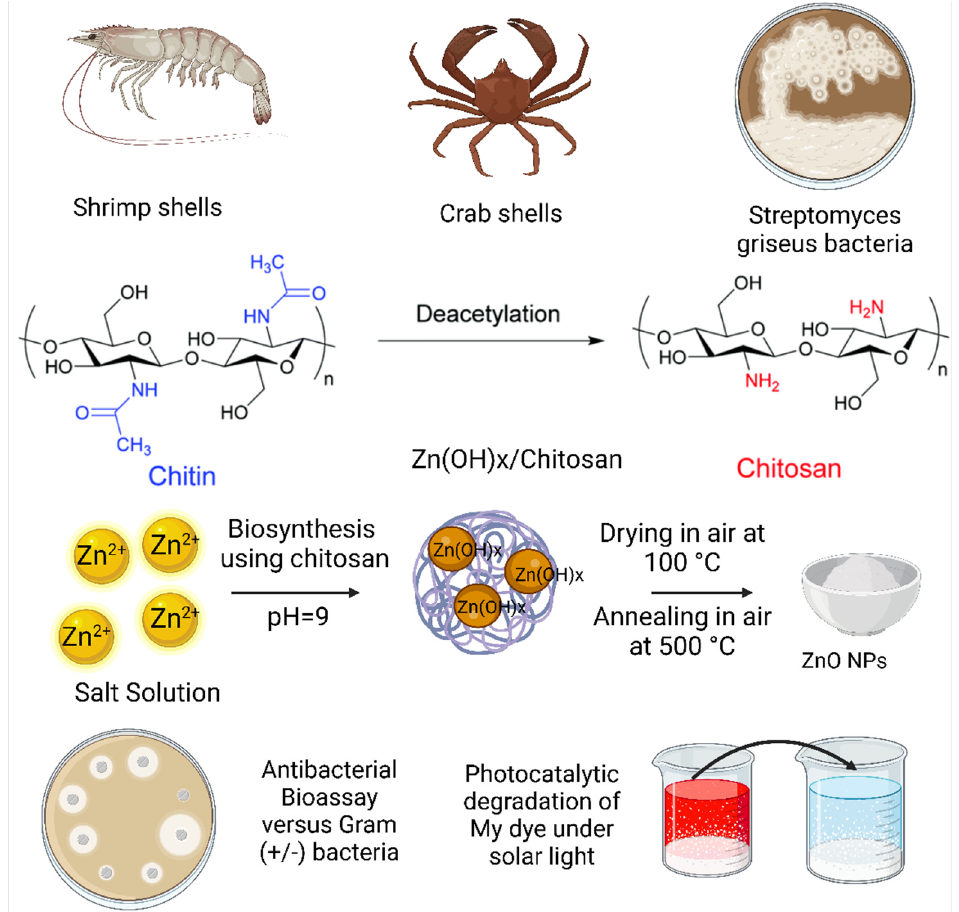
Figure 1. The schematic representation of the sol-gel synthesis of ZnO NPs using different types of chitosan (sources: shrimp shells , crab shells , and Streptomyces griseus bacteria ) and their application in antibacterial and photocatalytic degradation of MB dye.